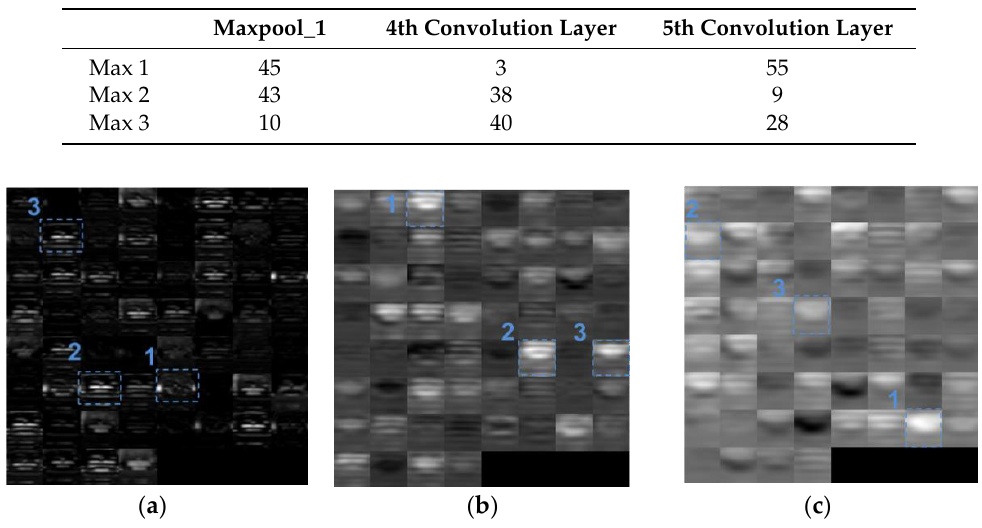
Figure 10. Top-three activation feature maps selected: ( a ) Maxpool_1 layer, ( b ) fourth convolution layer, and ( c ) fifth convolution layer.